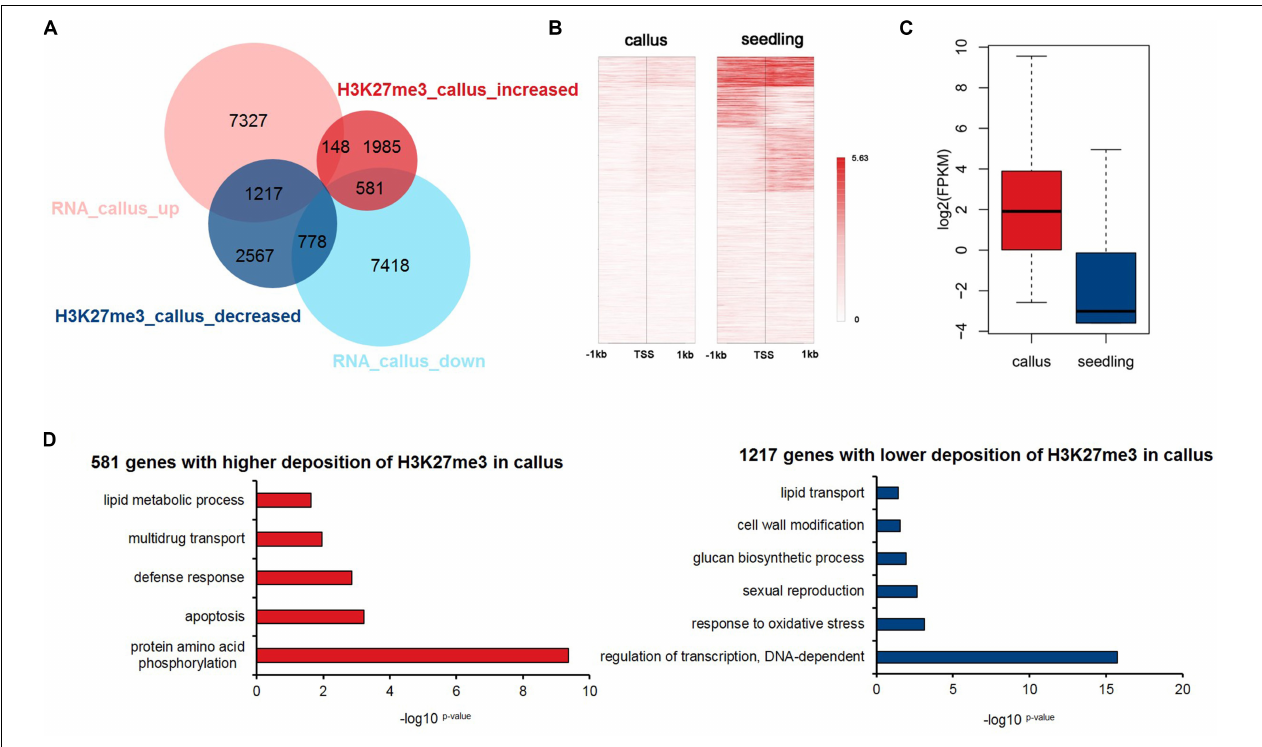
FIGURE 3 | Integrated analysis of H3K27me3-targeted and differentially expressed genes. (A) Venn diagrams for H3K27me3-targeted genes and differentially expressed genes between callus and seedling. (B) Heatmap of H3K27me3 deposition in 1,217 genes in (A) that show lower deposition of H3K27me3 and are highly expressed in the callus. (C) The gene expression values are shown for the group of 1,217 genes in (A) . (D) GO enrichment analysis of 581 and 1,217 genes with higher deposition of H3K27me3 and lower expression levels in callus and seedling,